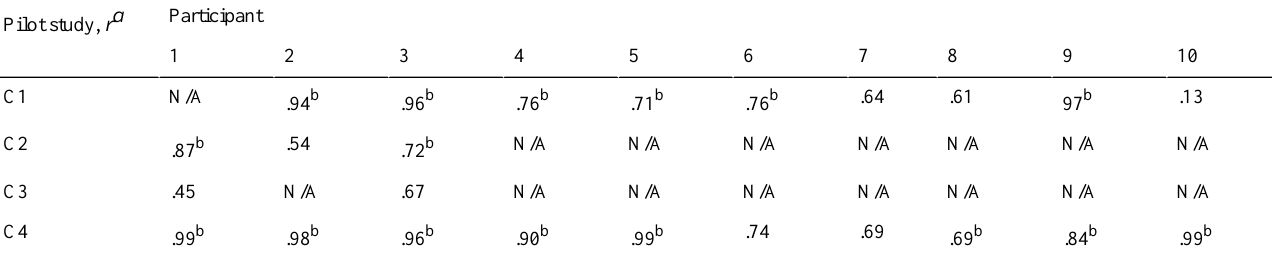
Table 3. Correlation between mobile phones and armband